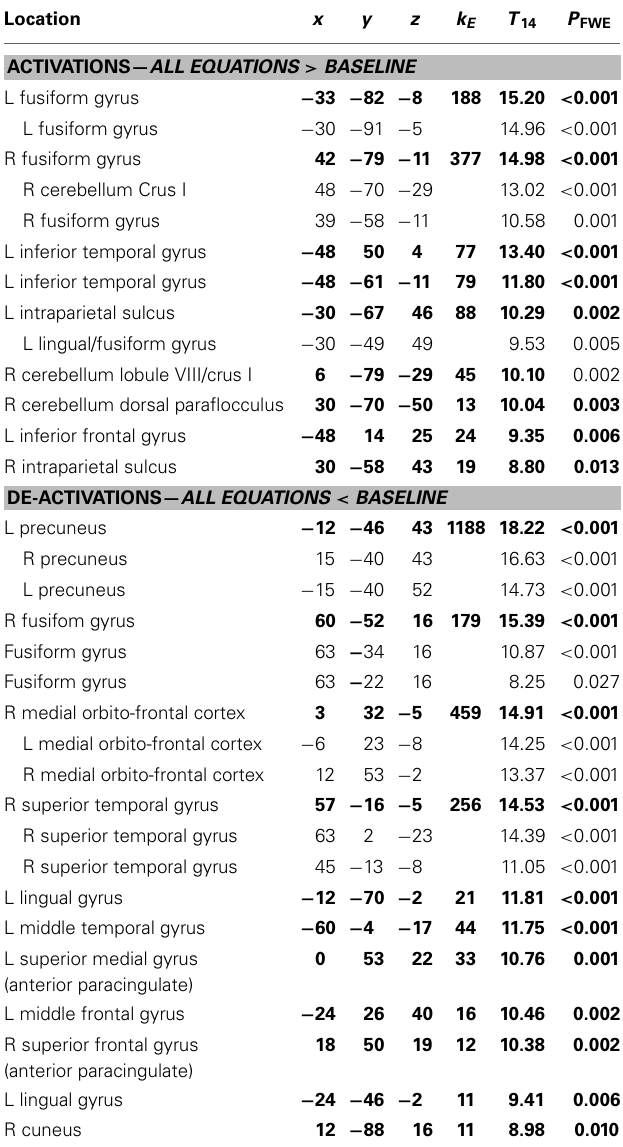
Table 3 | Activations and de-activations for the contrast all equations vs. baseline